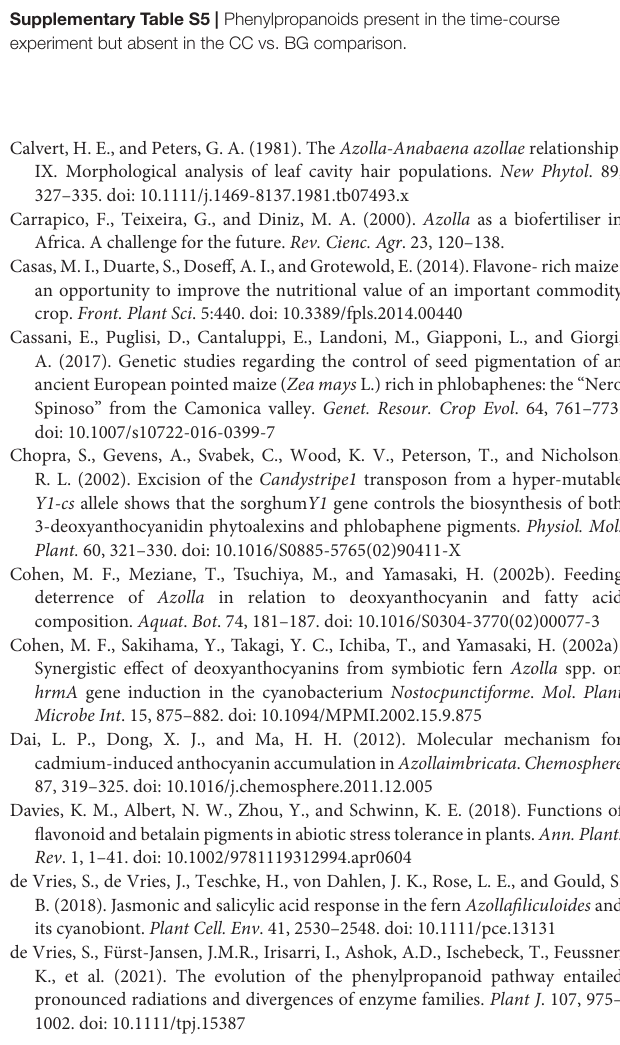
Supplementary Figure S5 | Principal component analysis (PCA) score plot of the 146 polyphenols annotated from the six replicated samples for each growing condition tested in the CC vs. BG comparison. Total quantitative variances were clustered to reveal differences and relative similarities of different samples. 95% Supplementary Figure S6 | Change in the color of Azolla fronds during the cold stress treatment under controlled conditions; on days (A) 0, (B) 1, (C) 2, (D) 3, and after (E) 20 days of treatment. Supplementary Figure S7 | Neighbor-joining tree of dihydroflavonol 4-reductase (DFR) proteins. The four DFR coding genes considered in this study are marked. The tree was built using 1,000 bootstraps. Supplementary Table S1 | Data annotation of metabolites. Supplementary Table S2 | List of the genes investigated by qRT-PCR analysis and sequence of the primers employed. Supplementary Table S3 | Metabolic data relative to the CC and BG